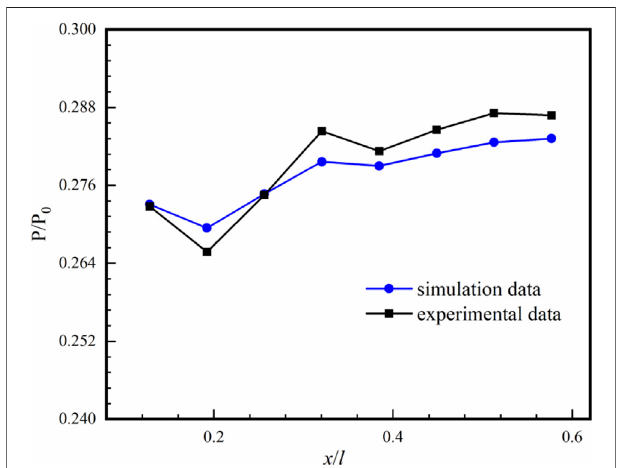
FIGURE 5 | Turbulence model validation: the value of P/P 0 on y-z sections along the streamwise direction at different locations between simulation and experimentation.